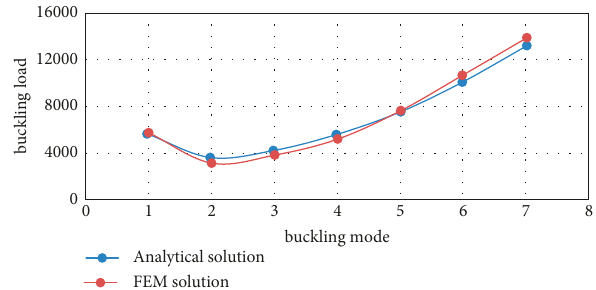
Figure 4: Comparison of the tension values from the software and analytical solution.